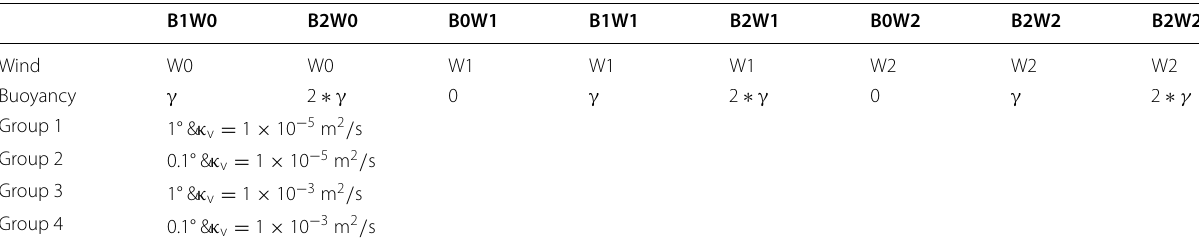
Table 1 Expeiment